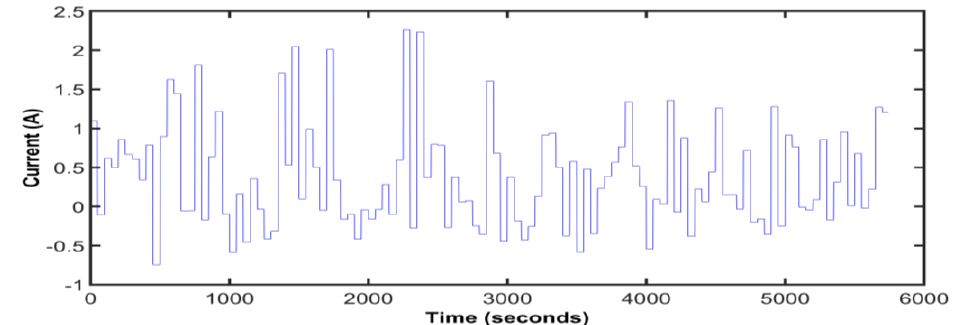
Figure 5. Current profile used for charging/discharging the battery pack on test for previous